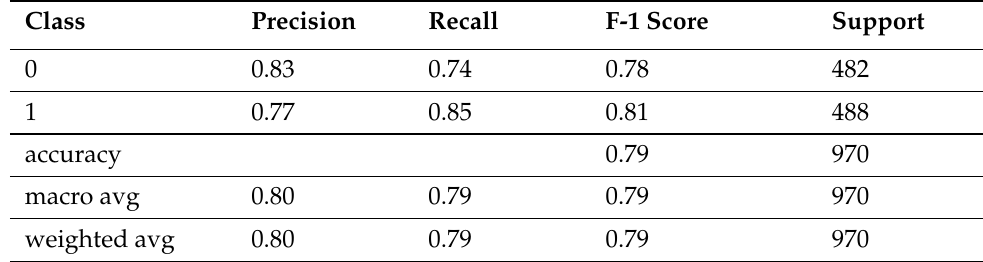
Table 7. Classification report for BoW with Naive Bayes.